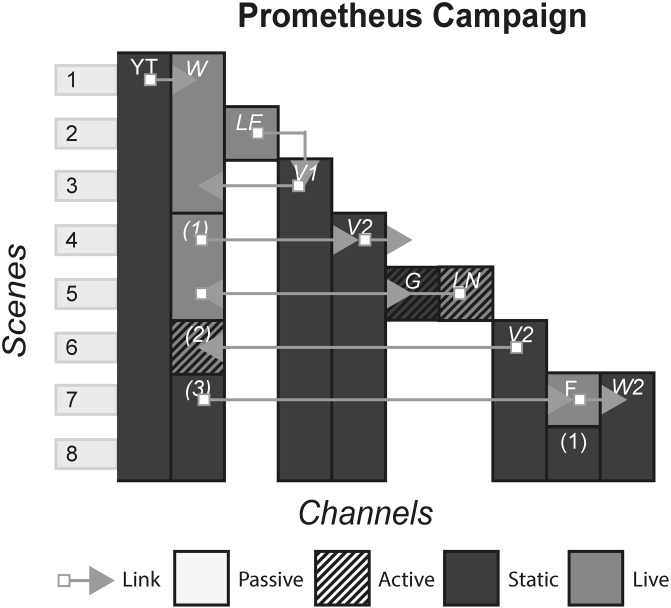
Prometheus campaign.